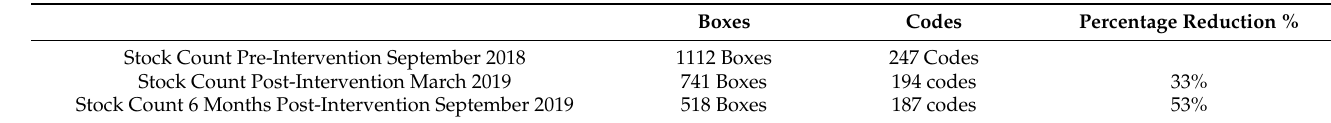
Table 4. Suture stock value.